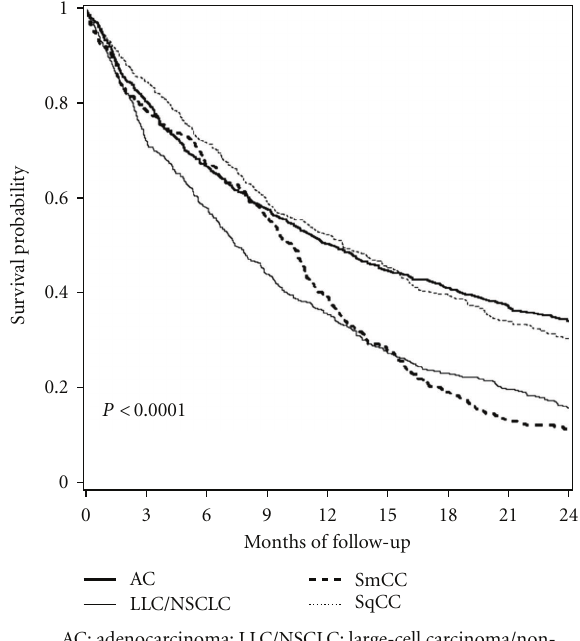
Figure 3: Short-term overall survival by lung cancer histotypes: Ticino,